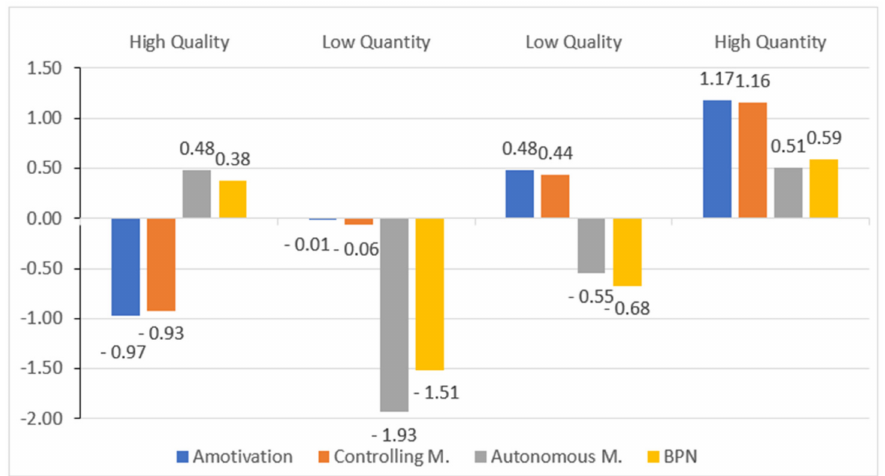
Figure 1. Student motivational